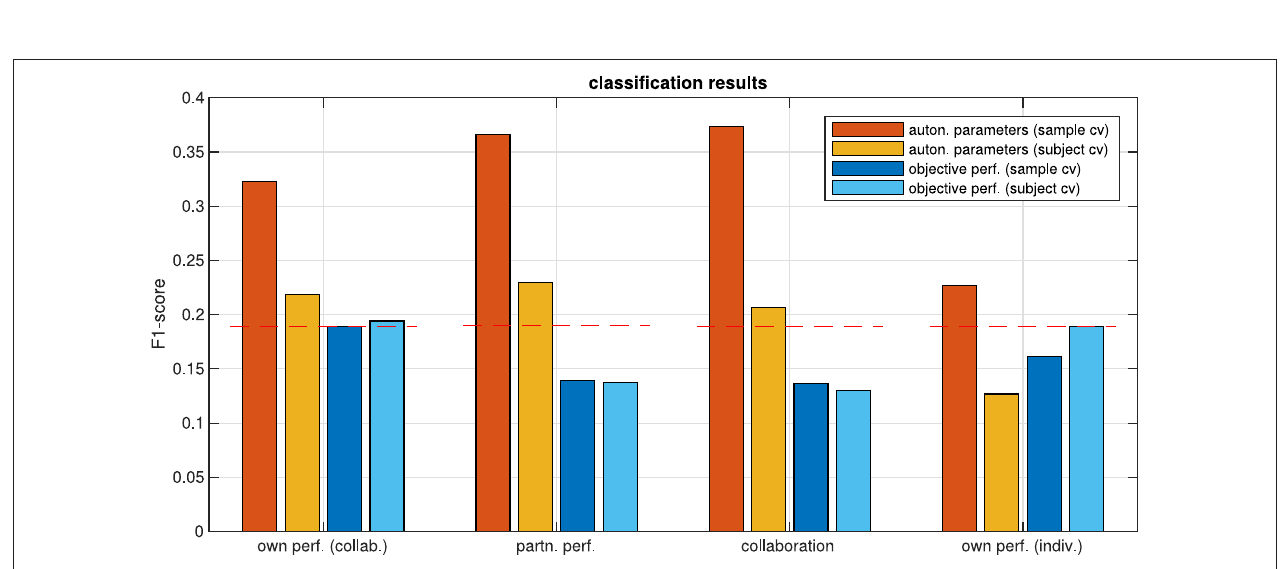
FIGURE 8 | F1-scores of predicting ratings from aggregated autonomic parameters and from objective performance, estimated using cross-validation on a single sample (sample cv) and on all samples from one subject (subject cv). Dashed red lines mark the 0.05 quantile of obtaining the corresponding F1-score or higher by chance